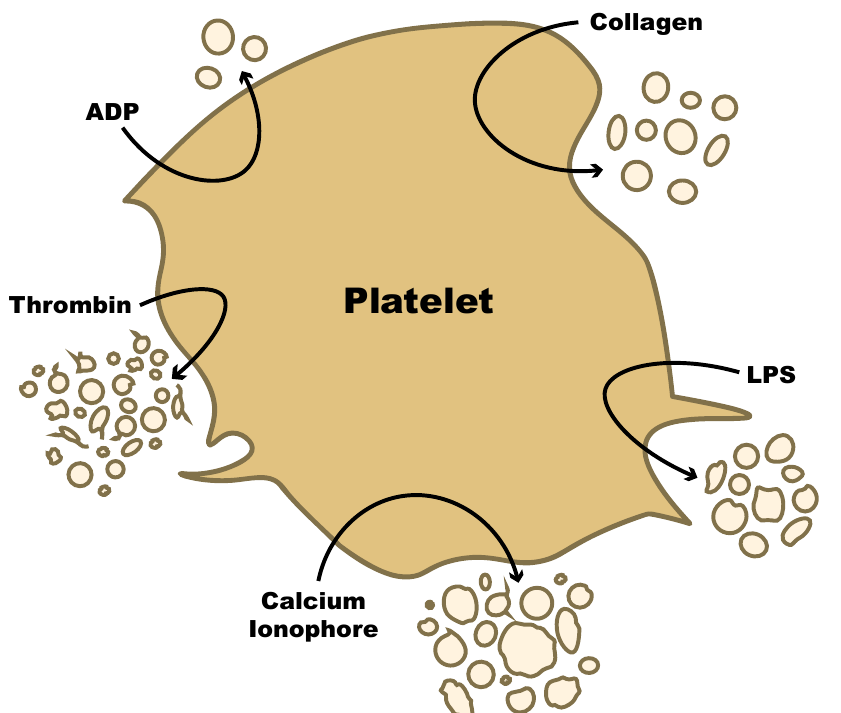
Figure 4. Diverse production of platelet-derived extracellular vesicles with different agonists. Platelets stimulated with different agonists produce extracellular vesicles (EVs) that are characteristically different. ADP and collagen stimulation produces spherical and smooth EVs and a higher number of EVS are produced with collagen. Thrombin stimulation produces an even larger number of EVs, but they are smaller, both spherical and elongated in shape, and have rough surfaces with thin offshoots. Calcium ionophore stimulation produces EVs that are larger and more heterogenous in size and have a rougher membrane surface. Included here is also LPS, a non-host derived stimuli, that leads to PEV production.